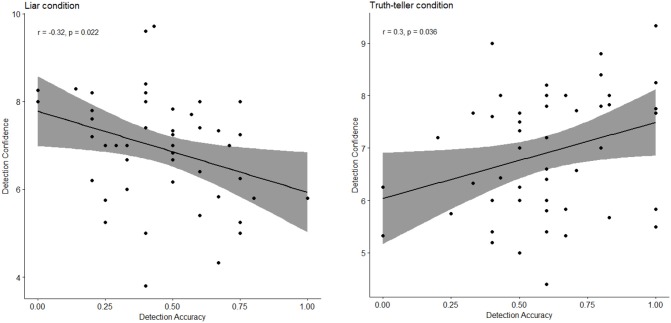
Scatterplot of correlations Detection Accuracy-Detection Confidence measures for judges' sample level (N = 50), for the liar (Left), and truth-teller conditions (Right).